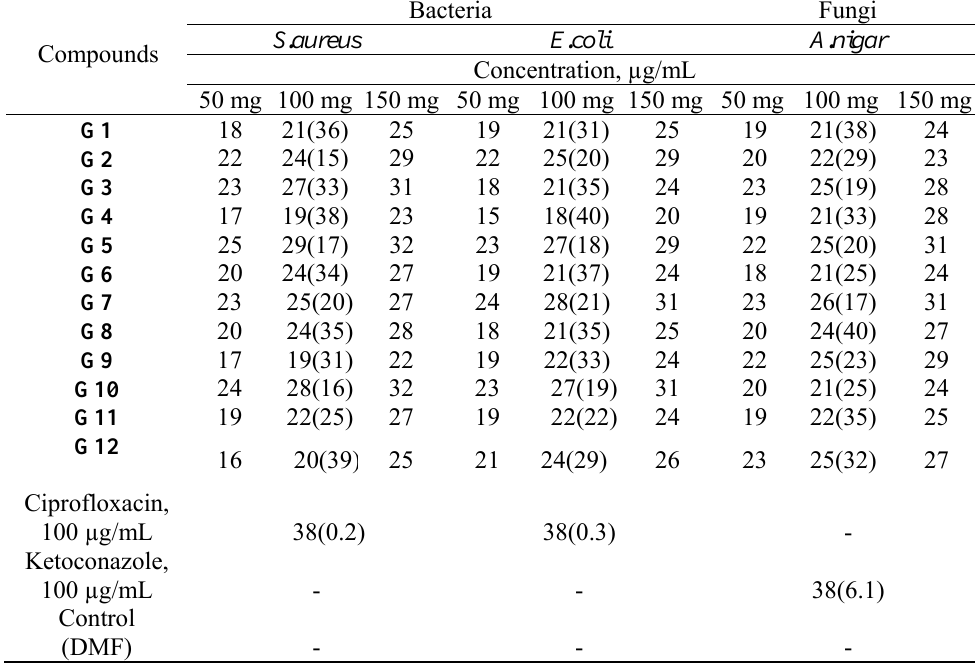
Table 1. Evaluation of antimicrobial activity of the compounds Bacteria